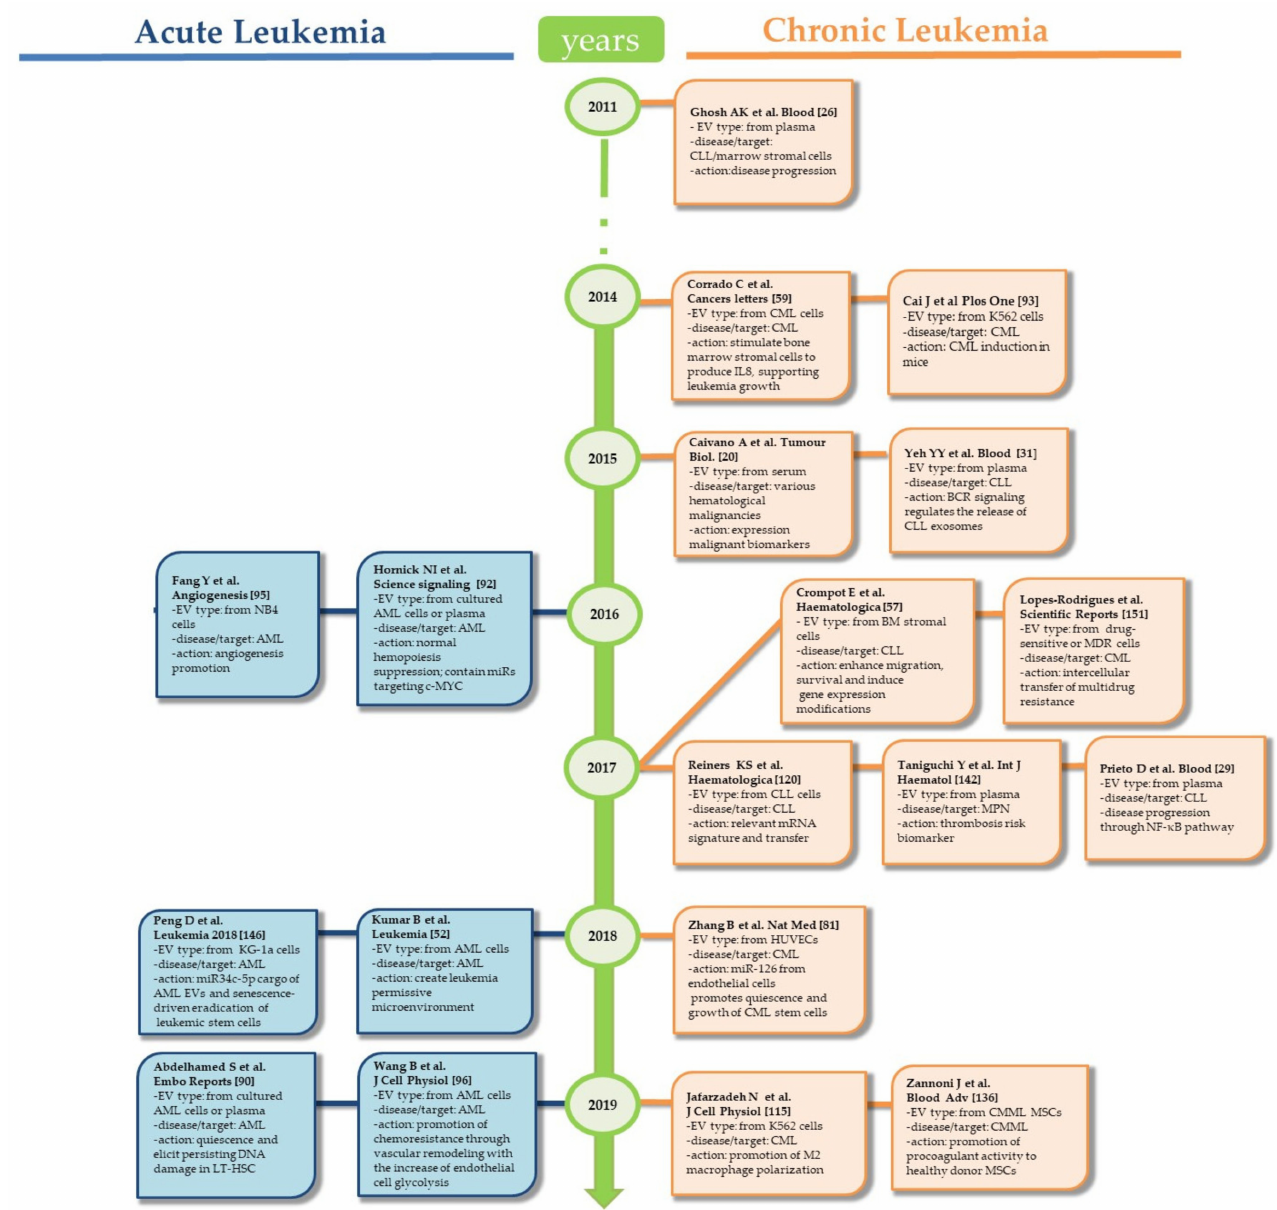
Figure 2. Timeline of key discoveries in EVs from